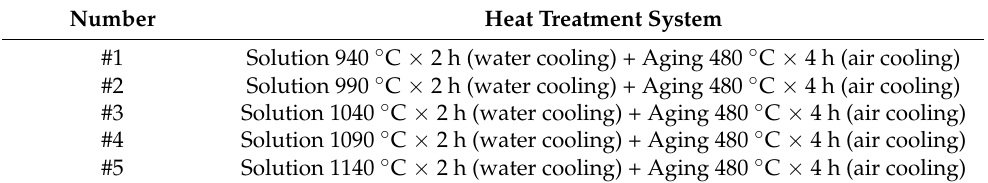
Table 3. The heat treatment system for the SLM-formed 17-4PH high-strength